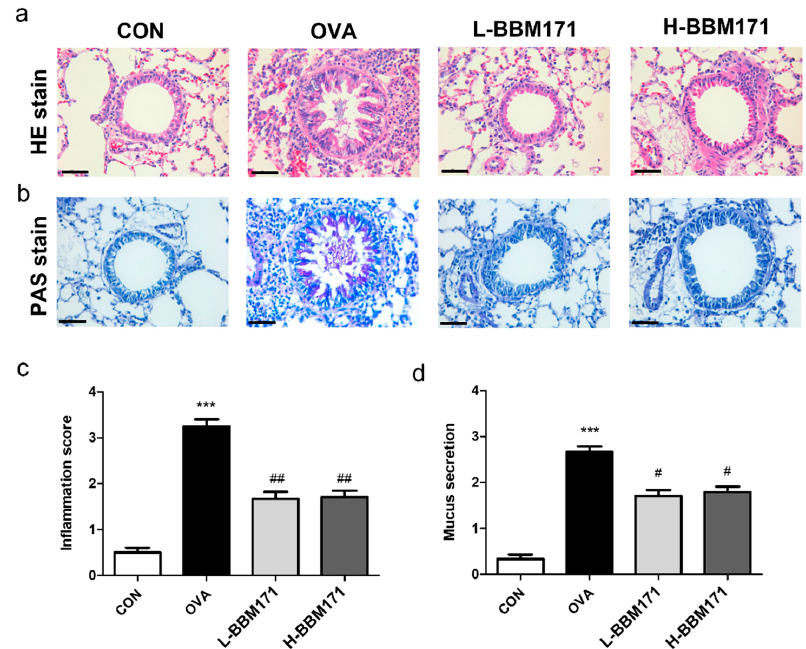
Figure 3. Oral administration of L. paragasseri BBM171 reduced inflammatory cell infiltration and the amount of mucus in the lung tissues of OVA-induced allergic mice. ( a ) Hematoxylin and eosin (H&E) staining. ( b ) Periodic acid-Schiff (PAS) staining. ( c ) The inflammation score represents the semi-quantitative results of airway inflammatory cells stained with H&E. ( d ) semi-quantitative results of mucus secretion stained with PAS. Bars = 50 µm. Data are expressed as mean ± SEM and analyzed by one-way ANOVA with Tukey’s post hoc test. Significant differences at *** p < 0.001 compared with the CON group. # p < 0.05 and ## p < 0.01 compared with the OVA group. 3.3. L. paragasseri BBM171 Attenuated the Accumulation of Inflammatory Cells in TheBALF To assess the effect of L. paragasseri BBM171 on OVA-induced recruitment and accu- mulation of inflammatory cells in the lungs, the levels of leukocytes and eosinophils in BALF were measured. Compared to the CON group, the levels of total leukocytes (Figure 4a) and eosinophils (Figure 4b) were significantly higher in the OVA group. However, these effects were alleviated by the supplementation of live or heat-inactivated BBM171.